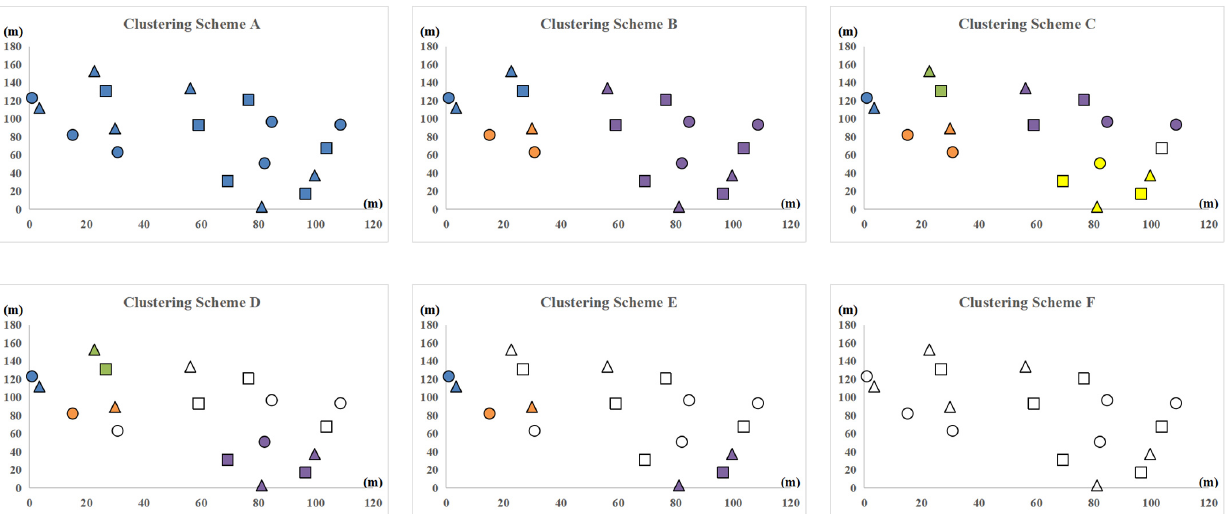
Table 7. The number of clusters in each clustering scheme.